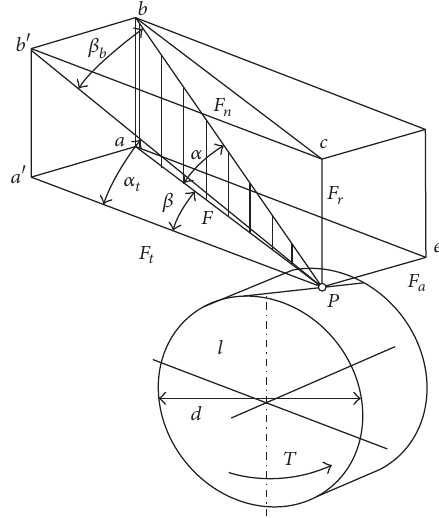
Figure 8: Force analysis of helical gears. where 𝐹 𝑡 is the circumferential force; 𝐹 𝑟 is the radial force; 𝐹 𝑎 is the axial force; 𝑇 is the torque; 𝑑 is the pitch diameter; 𝛼 is the pressure angle; 𝛽 is the helix